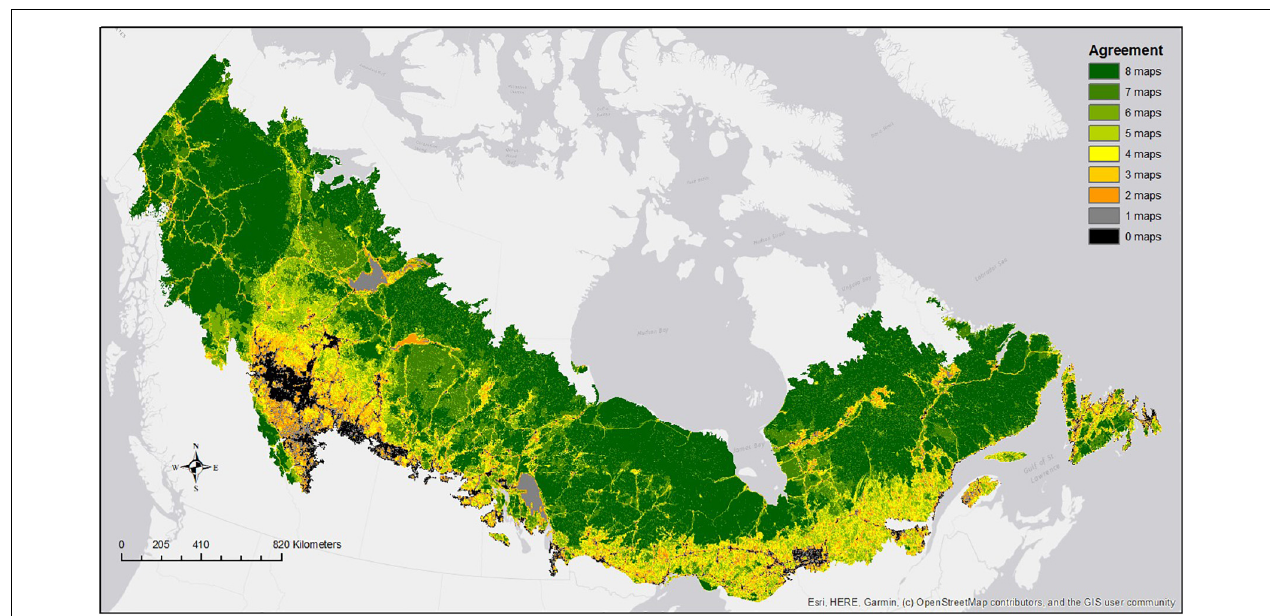
FIGURE 2 | Spatial agreement for intact areas amongst the eight most recent intactness ( N = 3) and human influence ( N = 5) maps. Dark green areas indicate areas identified as intact by all datasets. The percent area of agreement amongst 8 maps = 45.1%, among 7 maps = 62.4%, among 6 maps = 70.6%, among 5 maps = 78.5%, among 4 maps = 84.5%, among 3 maps = 89.7%, and among 2 maps = 93.6%. Only 3.6% of the area was identified by only 1 map and 2.8% by no